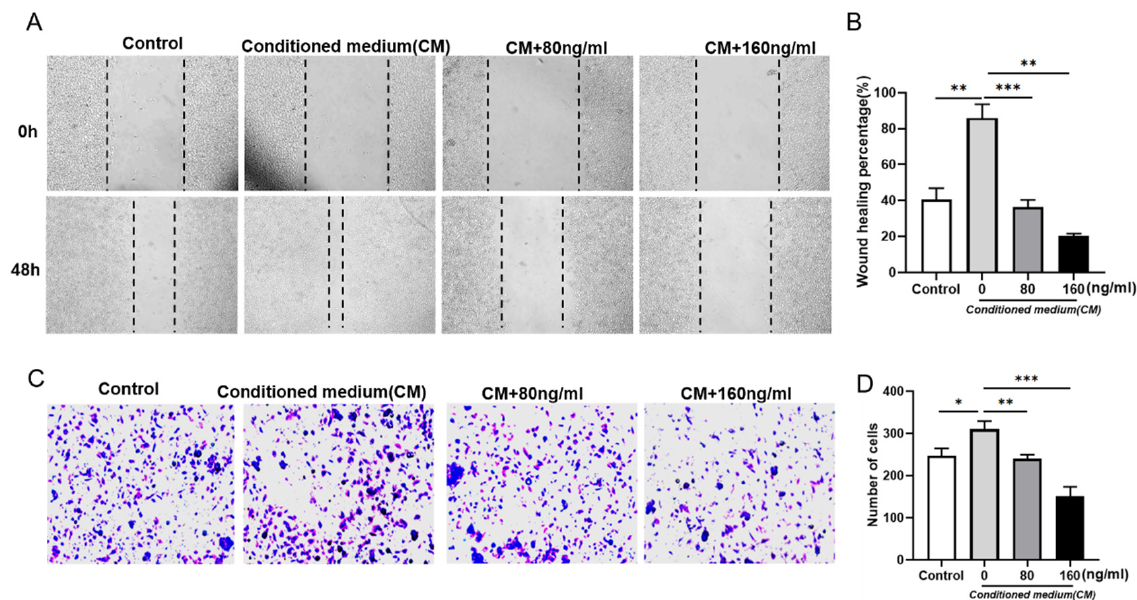
Figure 2. Effect of RT on B16F10 migration in tumor microenvironment. ( A ) Images of cell migration in each group within 48 h of scratch in wound healing experiment; ( B ) Statistics of wound healing area of B16F10 cells (** p < 0.01, *** p < 0.001). ( C ) Images of groups of cells passing through pores in the Transwell experiment; ( D ) Statistics on the number of B16F10 invaded cells (* p < 0.05, ** p < 0.01, *** p < 0.001).